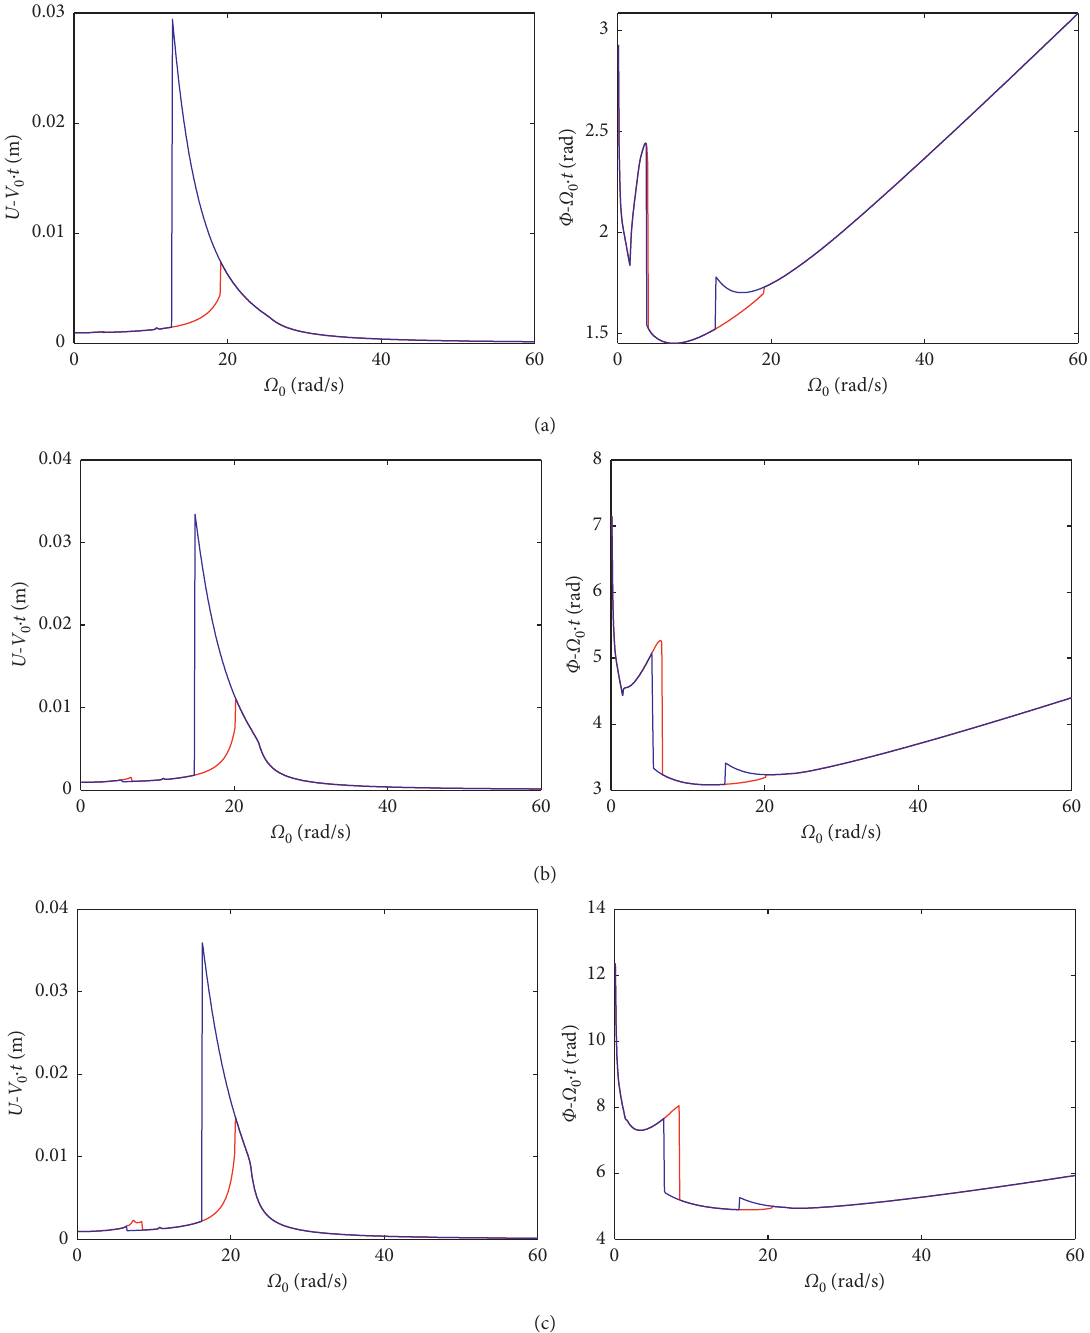
Figure 7: Amplitude-frequency response curves with different nominal drilling pressures k � and (c) W 0